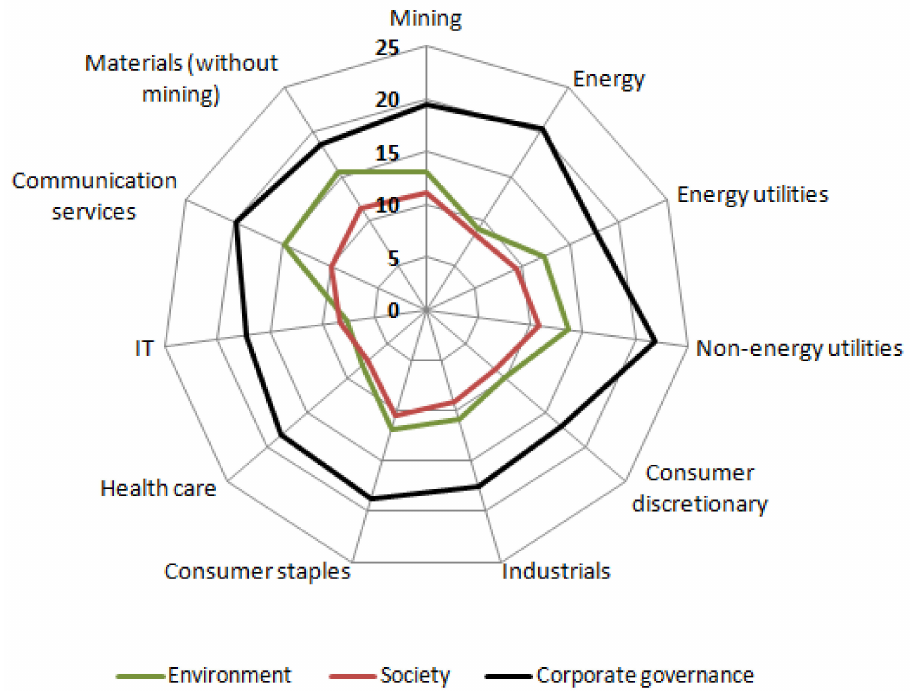
Figure 5. Total environmental, social, and corporate governance grades obtained by groups under